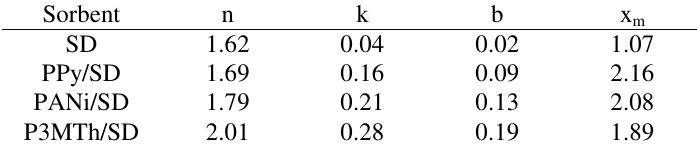
Table 2 Comparison of Freundlich and Langmuir constant values obtained for SD, PPy/SD, PANi/SD and P3MTh/SD